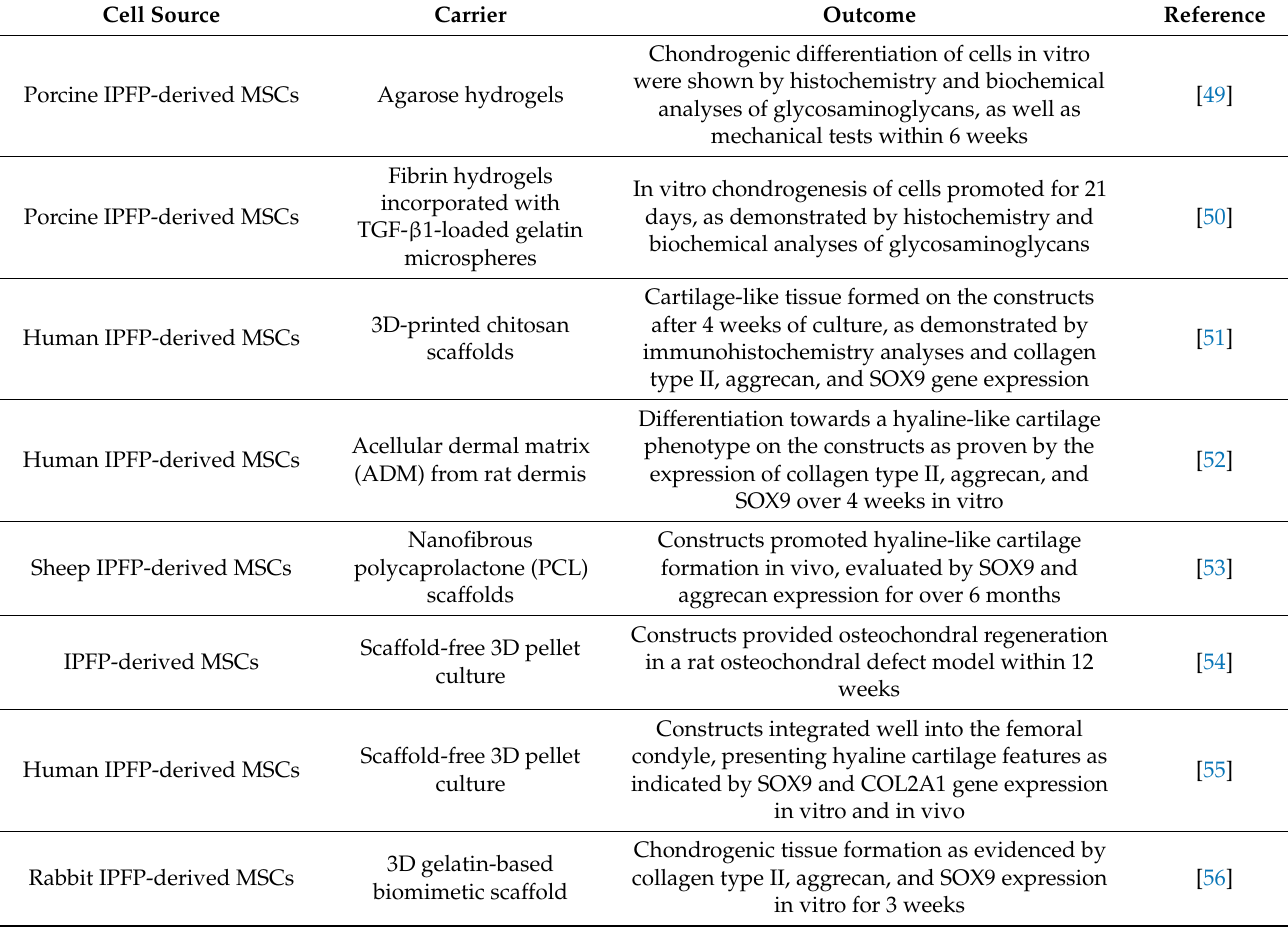
Table 3. Some important studies on IPFP-derived MSCs for articular cartilage repair that use a